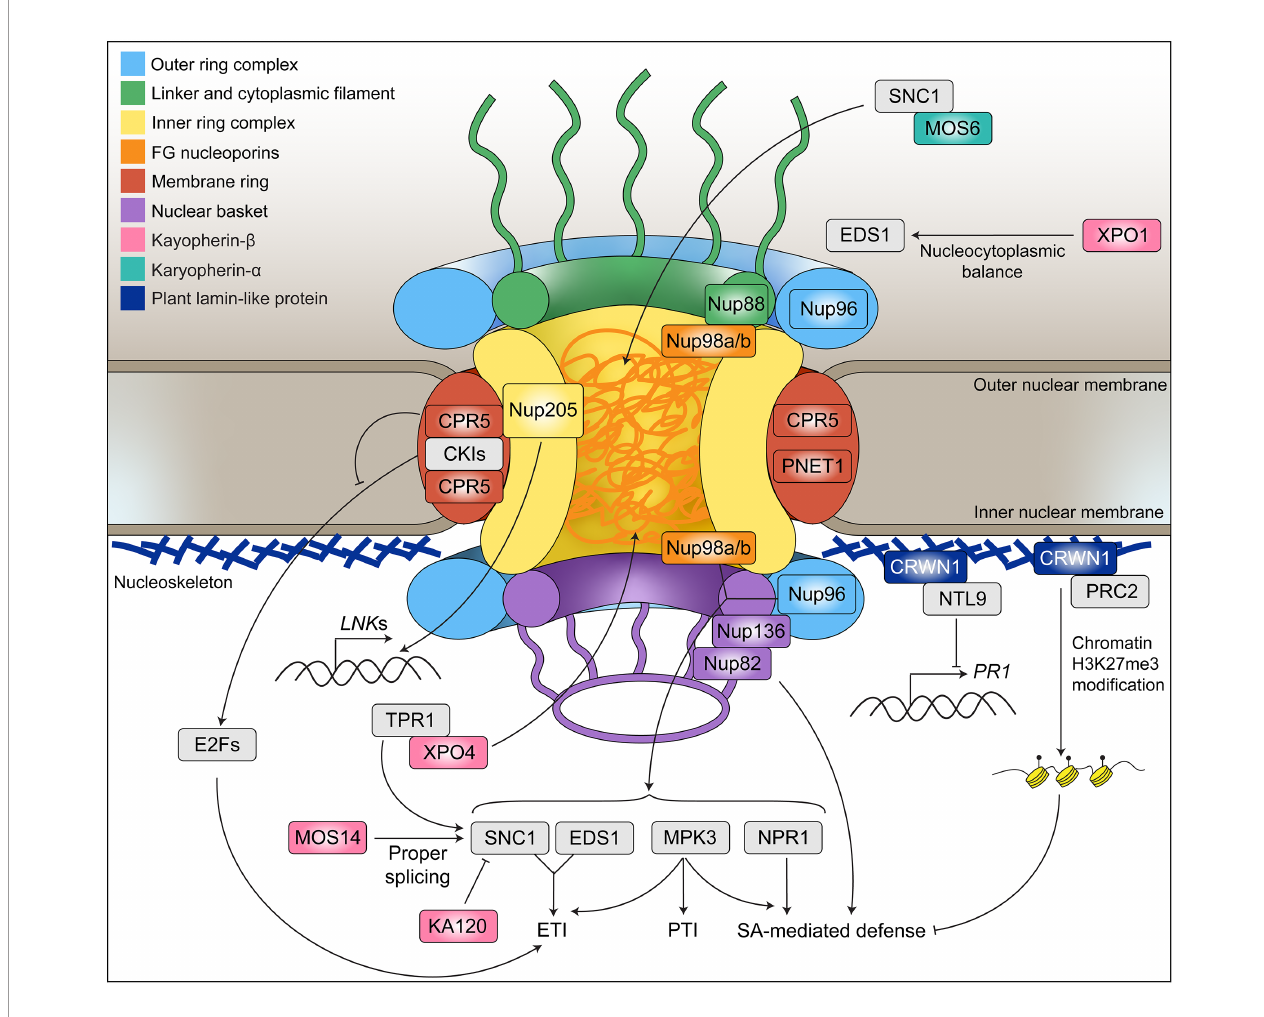
FIGURE 1 | Summary of the regulatory roles of nuclear membrane-associated proteins in plant immune pathways. Critical plant immune regulators that are subject to regulation by nuclear membrane-associated mechanisms include the NLR-type immune receptor SNC1 that activates effector-triggered immunity (ETI), the critical ETI signaling component EDS1 that acts downstream of SNC1, transcription corepressor TPL and TPRs that work together with SNC1 to activate defense gene expression, cell cycle transcription factor E2Fs that activate ETI in a noncanonical manner, the master regulator of SA-mediated immunity NPR1, the mitogen-activated protein kinase MPK3 that widely participates in various types of plant immune responses including PTI, ETI, and basal resistance, core clock regulator LNKs that are required for basal resistance, and the transcription factor NTL9 that represses defense gene (e.g. PR1 ) expression. The outer ring complex (ORC) of the nuclear pore complex (NPC) is required for SNC1-mediated immune activation and basal resistance. As components of the central channel barrier, FG nucleoporin Nup98 and Nup88 are required for nuclear accumulation of SNC1, EDS1, NPR1, and MPK3. The membrane nucleoporin CPR5 (part of the NPC membrane ring) gates ETI activation by sequestering cyclin kinase inhibitor SIM/SMR1 and preventing E2F activation. Nup205 is required for the proper expression of LNK family genes and activation of basal resistance. Nup82 and Nup136 are involved in SA-mediated defense activation. Karyopherin- a MOS6 serves as the possible importin adapter for multiple NLR proteins, including SNC1 and TN13. Karyopherin- b KA120 is required for suppressing the nuclear activity of SNC1 and prevents SNC1 autoimmune activation. XPO4 mediates TPR1 nuclear export and negatively regulates SA-mediated immune ampli fi cation during ETI. MOS14 is required for proper splicing of NLR genes, including SNC1. The nucleoskeleton protein CRWN1 plays a role in suppressing both SA responses through interacting with transcription factor NTL9 that represses defense gene PR1 expression and interacting with epigenetic regulator PRC2 that facilitates the H3K27me3 of genes promoting SA